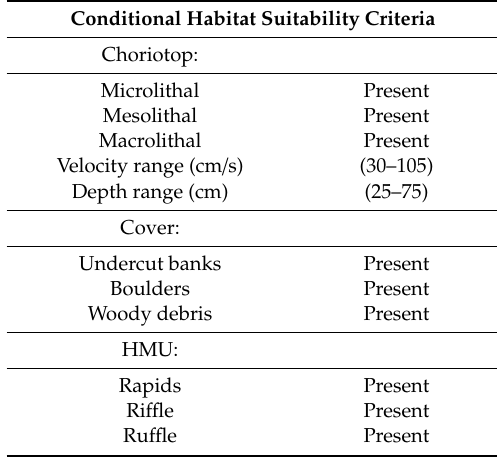
Table 3. Physical habitat attributes used in the conditional habitat suitability criteria (CHSC) model, based on expert knowledge and supplemented by literature data for